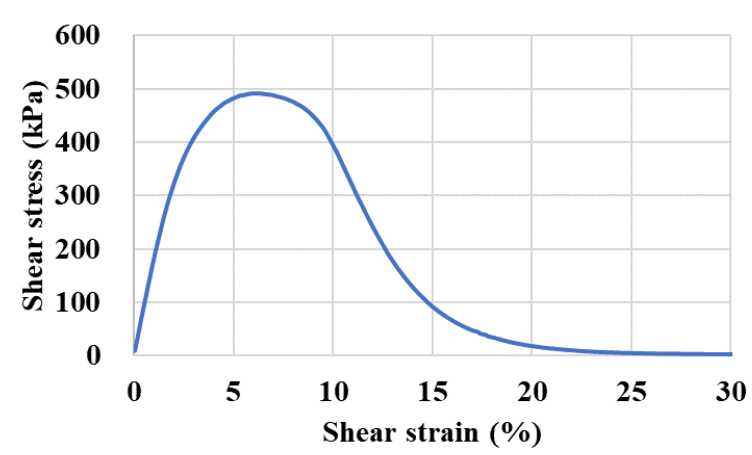
Figure 4. A typical shear strain-stress curve in a LAS